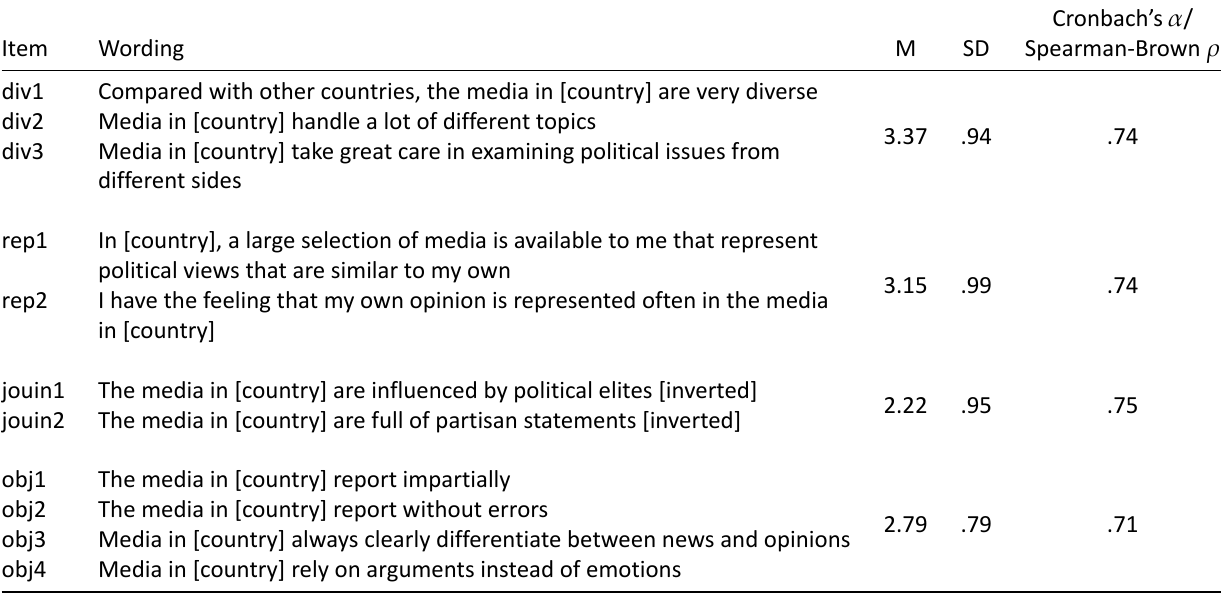
Table 1. Item wording of media performance